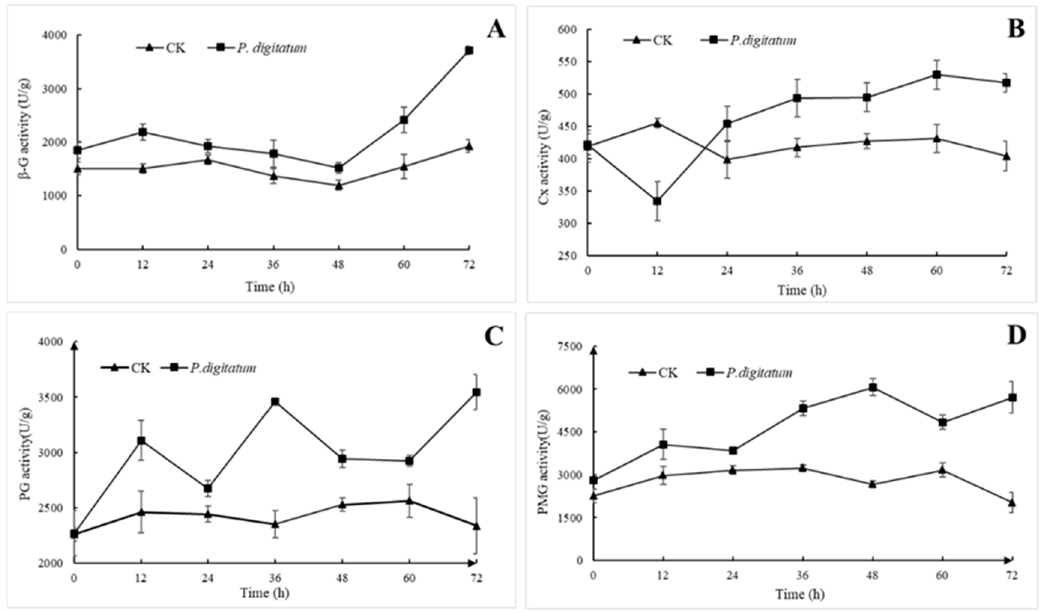
Figure 4. Effects of P. digitatum on cell wall degrading enzyme activity of citrus wound tissues at 25 °C . ( A ): Beta-glucosidase ( β -G) activity; ( B ): exo-1,4-beta-glucanase (Cx) activity; ( C ): polygalacturonase (PG) activity; ( D ): pectin methylgalacturonase (PMG) activity. CK: Citrus inoculated with water. Each value is the mean of three experiments. Bars represent the standard deviation of the mean.